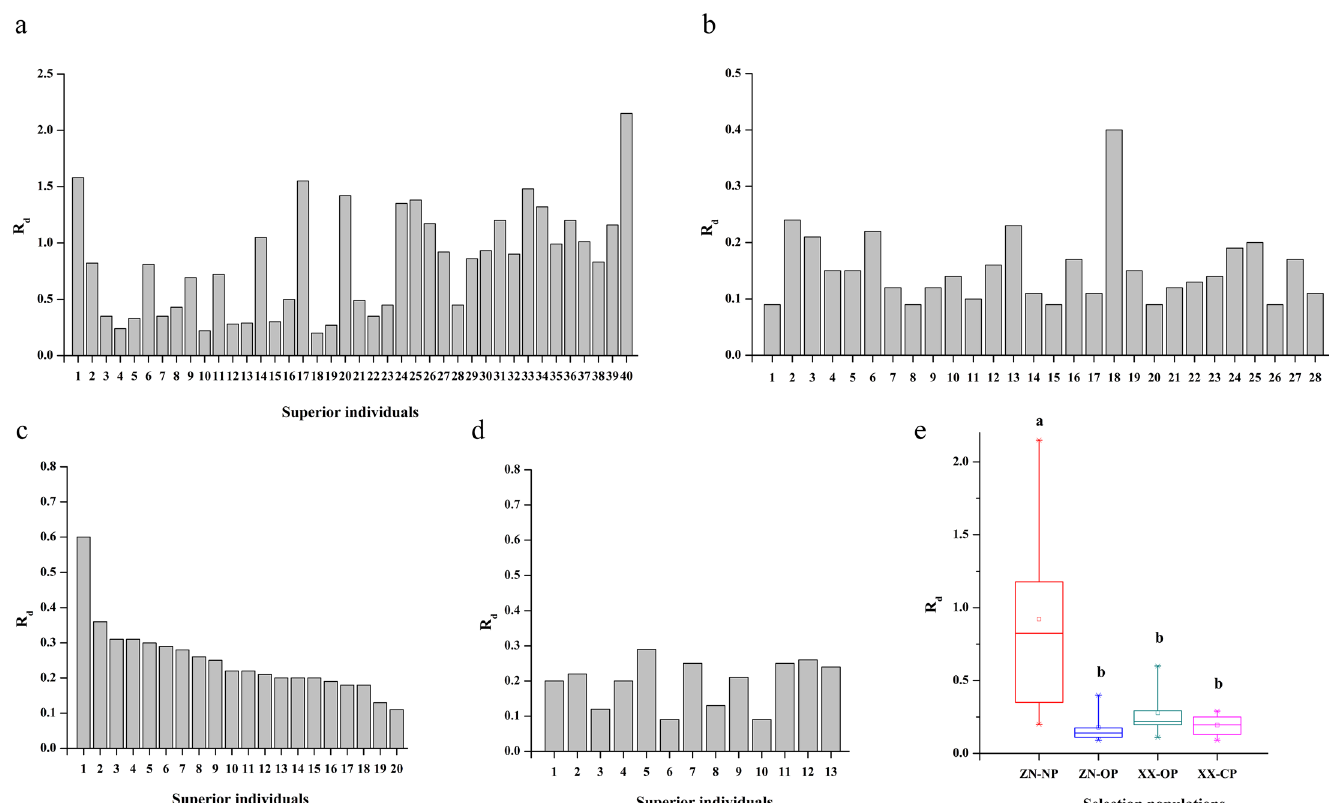
Fig 1. Volume dominance ratios (R d ) of the second-generation selected populations of Chinese pine. Comments: (a) Volume dominance ratios of superior individuals in the ZN-NP selected population; (b) volume dominance ratios of superior individuals in the ZN-OP selected population; (c) volume dominance ratios of superior individuals in the XX-OP selected population; (d) volume dominance ratios of superior individuals in the XX-CP selected population; (e) Variations in volume dominance ratios among the four selected populations.